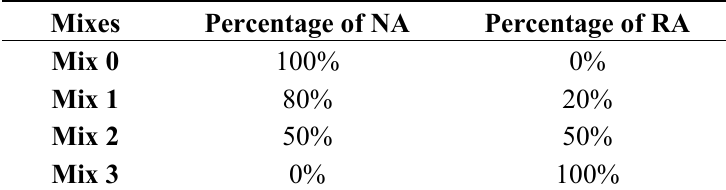
Table 2. Proportions of natural and recycled aggregate used in the different concrete mixtures.